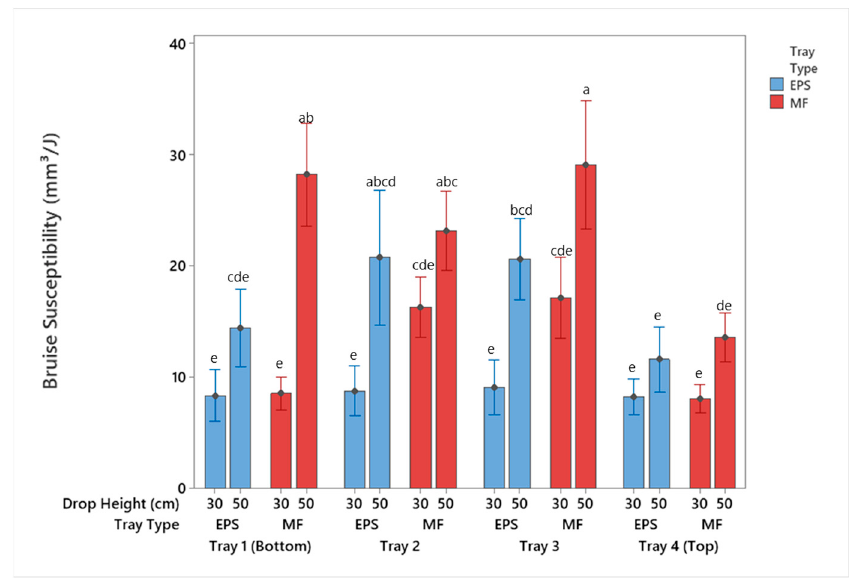
Figure 8. Bruise susceptibility of apples by tray location packaged using MF and EPS trays from 30 and 50 cm drop height (mean ± SD, n = 2). Different letters indicate statistically significant differences at p < 0.05. Bars with no common letters are significantly different ( p < 0.05).